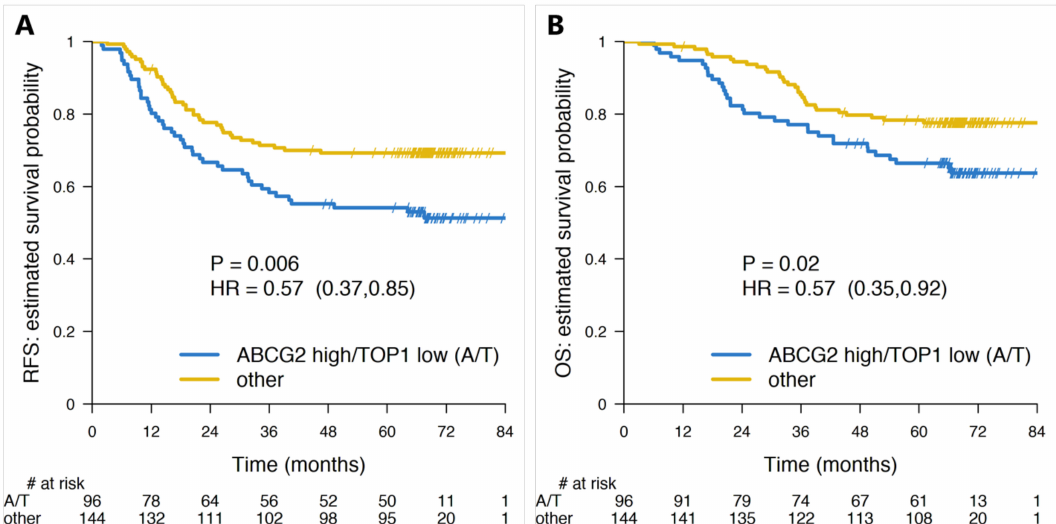
Figure 3. Survival plots (Kaplan-Meier estimates) for “resistant” (ABCG2-high / TOP1-low, abbreviated A / T under the plots) and “sensitive” (all other combinations of ABCG2 and TOP1 genes) patient groups in stage III / MSS (Microsatellite Stable) subset ( n = 470). The two plots show the ( A ) Recurrence free survival (RFS) and ( B ) Overall Survival (OS) of “resistant” (blue line) and “sensitive” (gold line) under FOLFIRI treatment, respectively. Numbers at risk are given under each